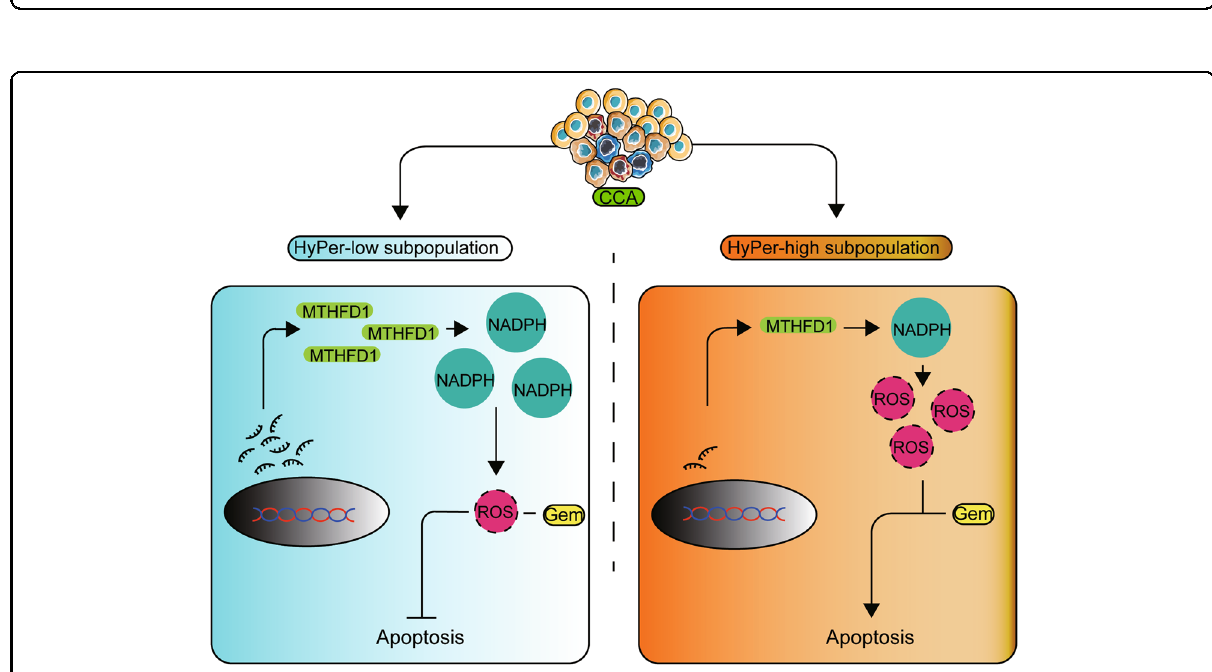
clinical practice over the years, gemcitabine has been broadly used for its capacity to induce apoptosis either single-use in pancreatic cancer or combined-use in non- small cell lung cancer, bladder cancer, breast cancer, etc.,